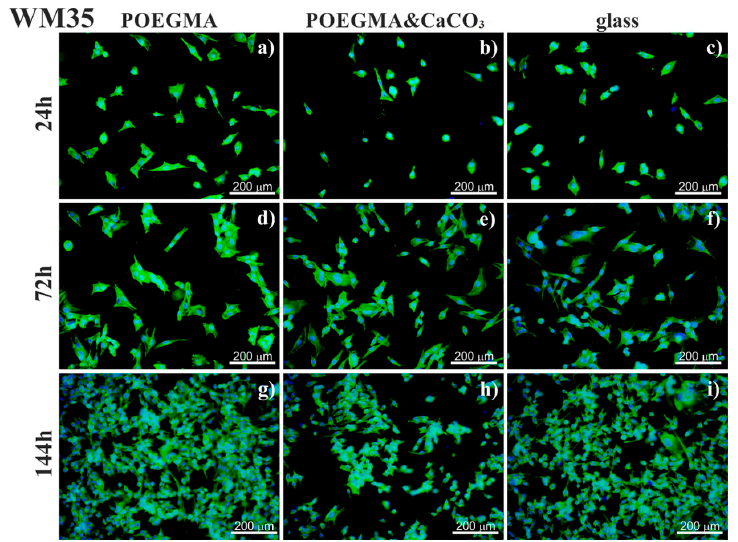
Figure 8. Impact of glass surface, POEGMA and POEGMA-grafted brush coatings with incorpo- rated CaCO 3 NPs on the amount ( a ), viability ( b ) and proliferation index ( c ) of HaCaT cells (*, ** significantly different from each other, p < 0.05). Data are presented as a mean ± standard deviation (SD) from n = 10 repetitions.